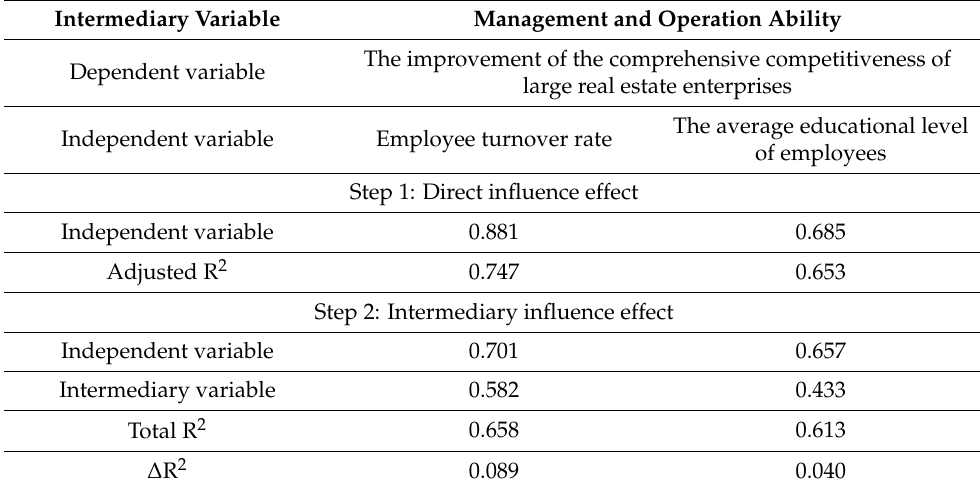
Table 7. Test results of the intermediary effect of management and operation ability.